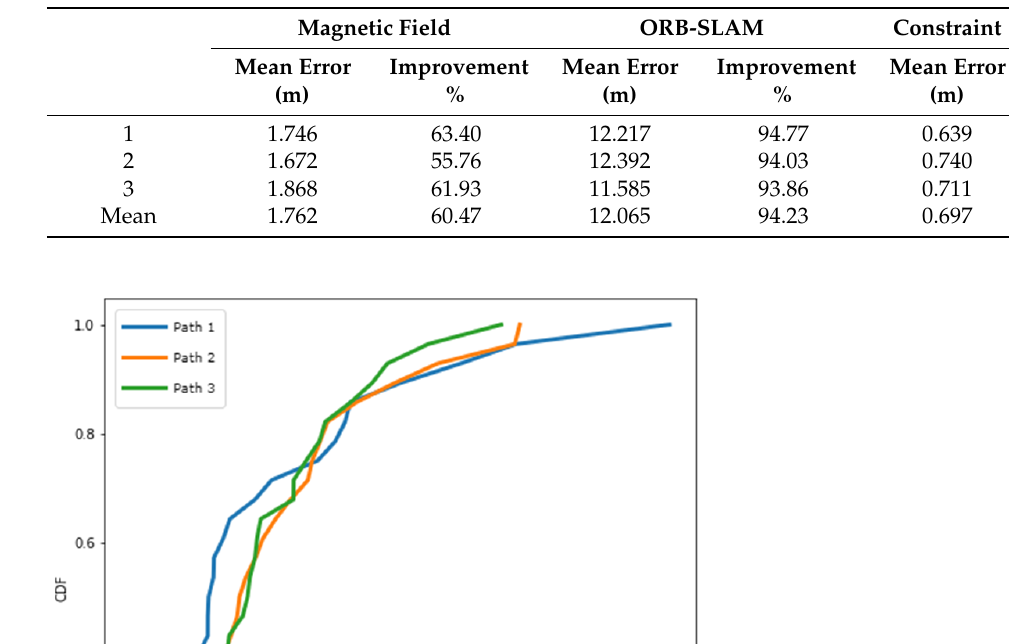
Table 7. Comparison of positioning results using different methods (Galaxy Note 9).